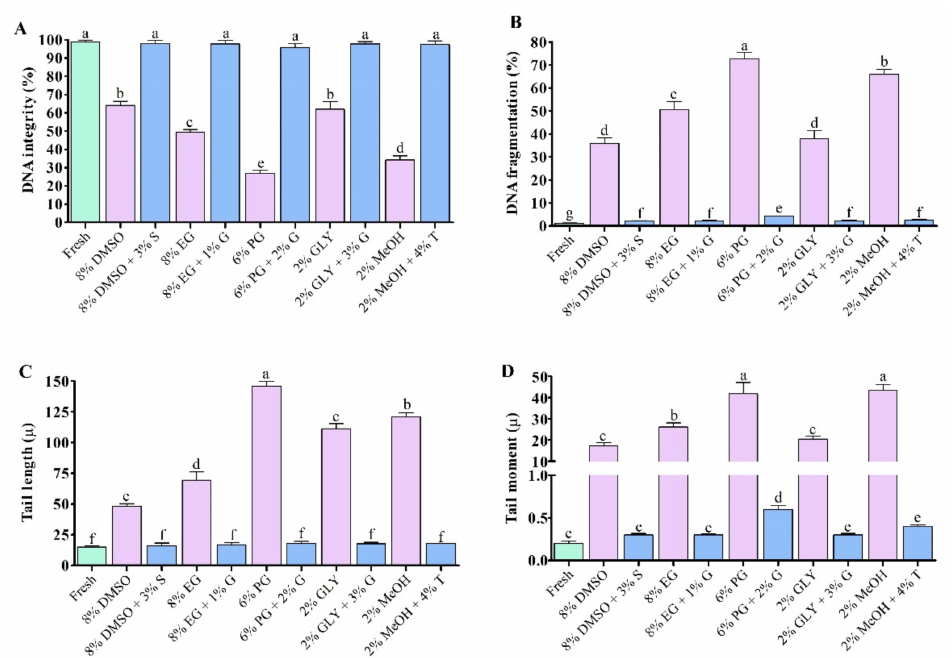
Figure 4. Comet assay parameters of sperm cryopreserved using different types of saccharides. ( A ) DNA integrity, ( B ) DNA fragmentation, ( C ) Tail length, and ( D ) Tail moment of sperm cryop- reserved using different types of saccharides. Results are presented as mean values ± standard deviation ( n = 5). DMSO: dimethyl sulfoxide, EG: ethylene glycol, PG: propylene glycol, GLY: glyc- erol, MeOH: methanol, S: sucrose, G: glucose, T: trehalose. Significantly different levels ( p < 0.05)